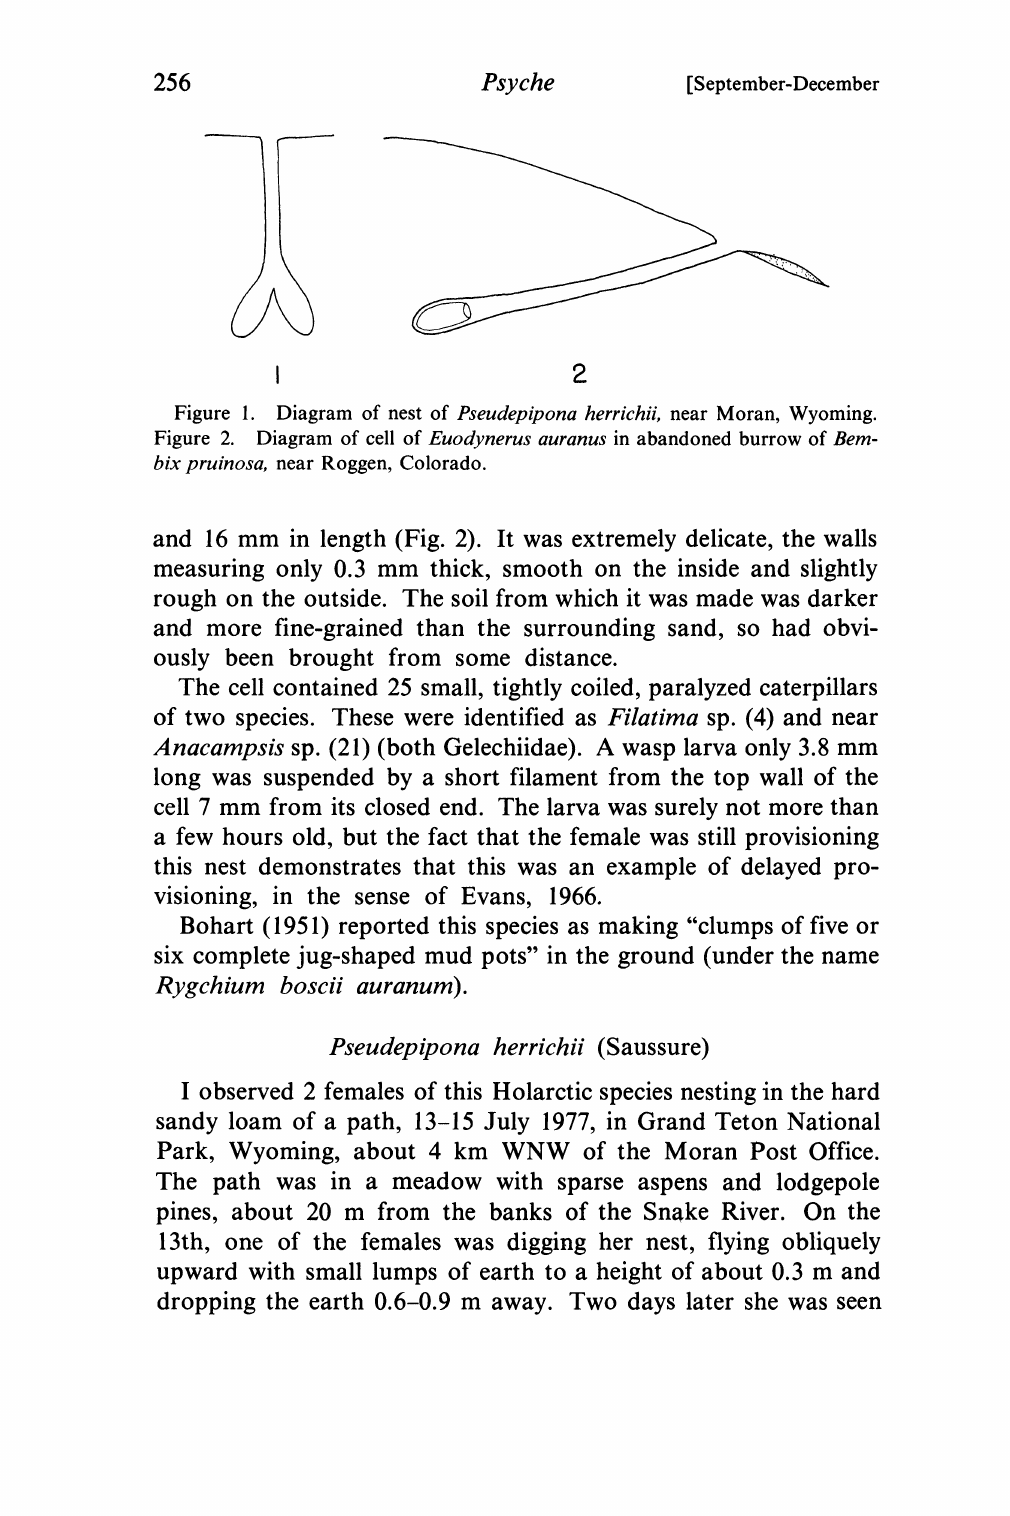
Figure 1. Diagram of nest of Pseudepipona herrichiL near Moran, Wyoming. Figure 2. Diagram of cell of Euodynerus auranus in abandoned burrow of Bem- bix pruinosa, near Roggen,